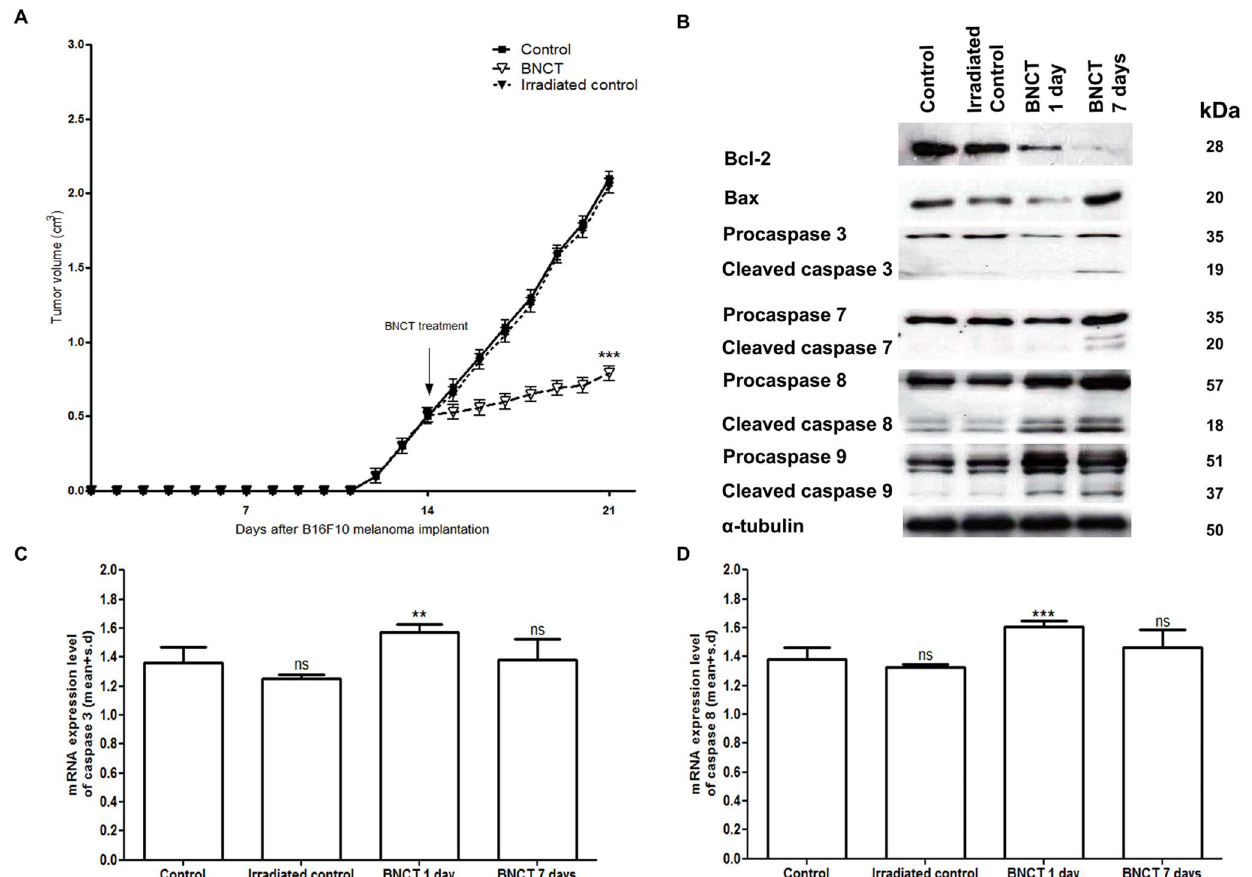
Figure 6. Melanoma cell death after BNCT. (A) Tumor volume of mice bearing B16F10 melanoma during twenty-one days. On the fourteenth day after B16F10 melanoma implantation, the BNCT group received BPA and was irradiated with thermal neutrons. The mice were sacrificed and analyzed 1 or 7 days after BNCT treatment. (B) Western blotting analyses of caspase 3, 7, 8, 9, Bcl-2 and Bax in melanoma tissue. (C, D) mRNA expression levels of caspase 3 and 8, respectively, quantified by